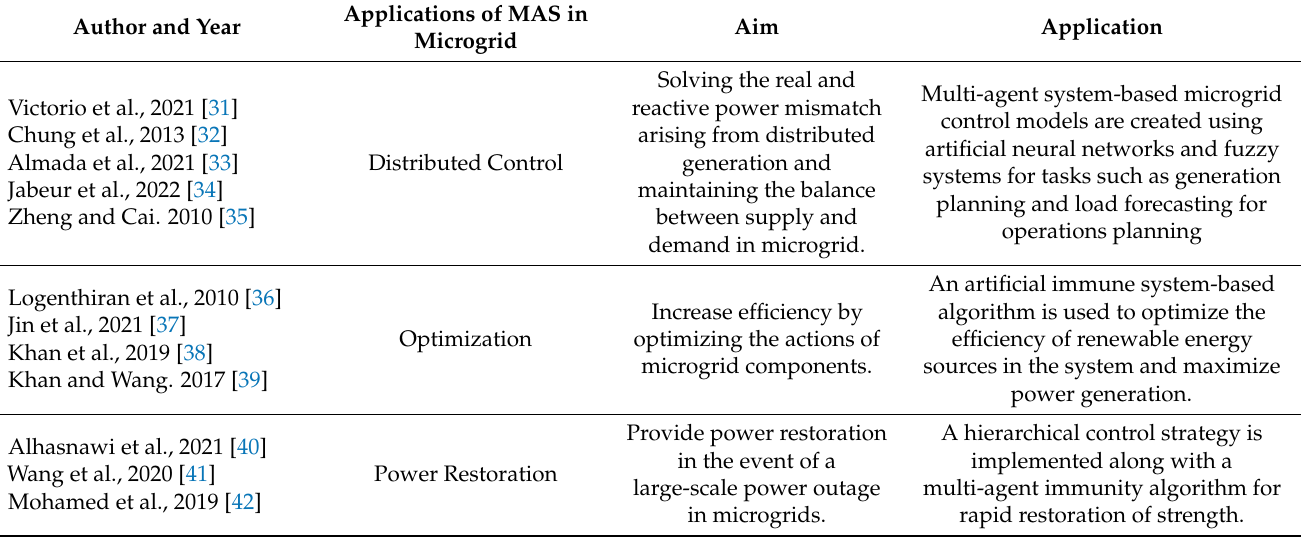
Table 1. Control subjects in the microgrid in which multi-agent system-based control is